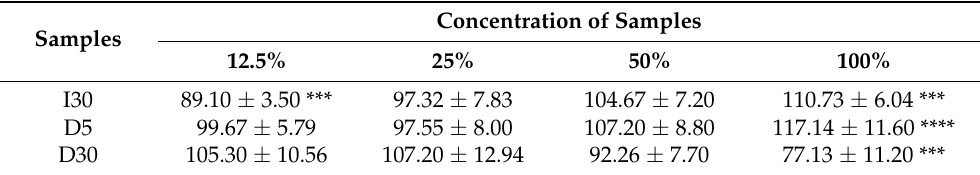
Table 4. Cell viability of the samples (mean ± SD).